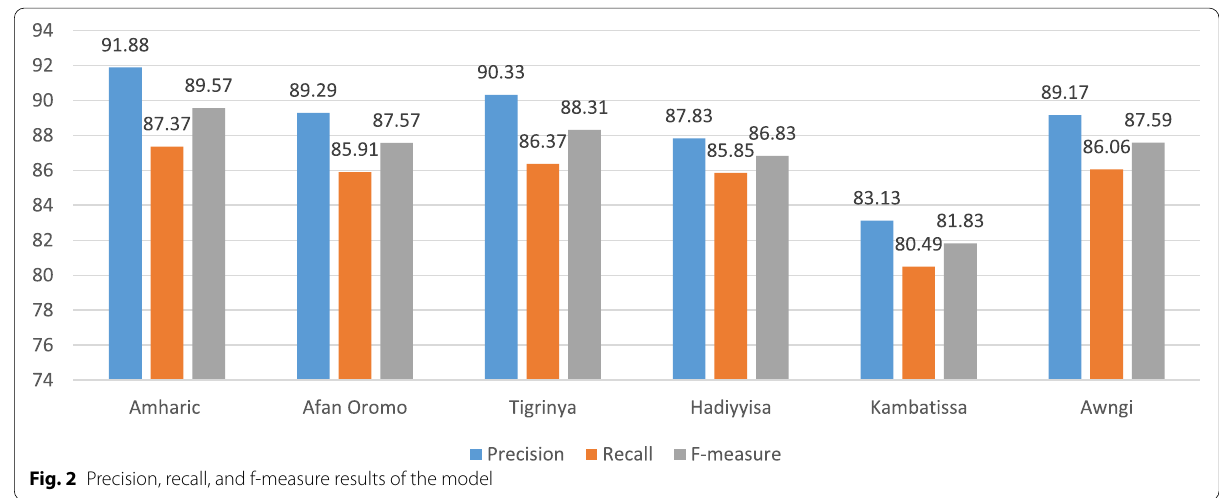
Fig. 2 Precision, recall, and f-measure results of the model